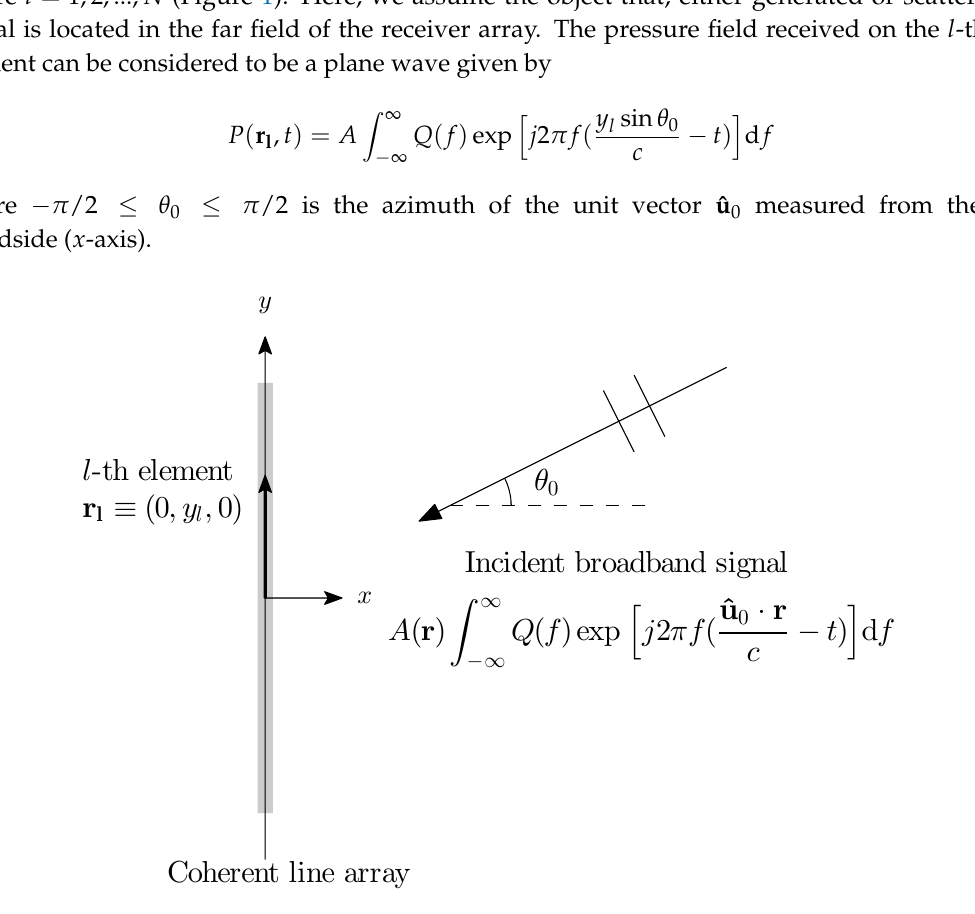
Figure 1. A sketch of the array geometry and incident plane wave field. The nonuniformly-spaced linear array is aligned horizontally along the y -axis in the ocean waveguide with elements located at r l = ( 0, y l ,0 ) . The incident broadband signal is propagated in the direction of the unit vector ˆu 0 , whose azimuth is θ 0 measured from array